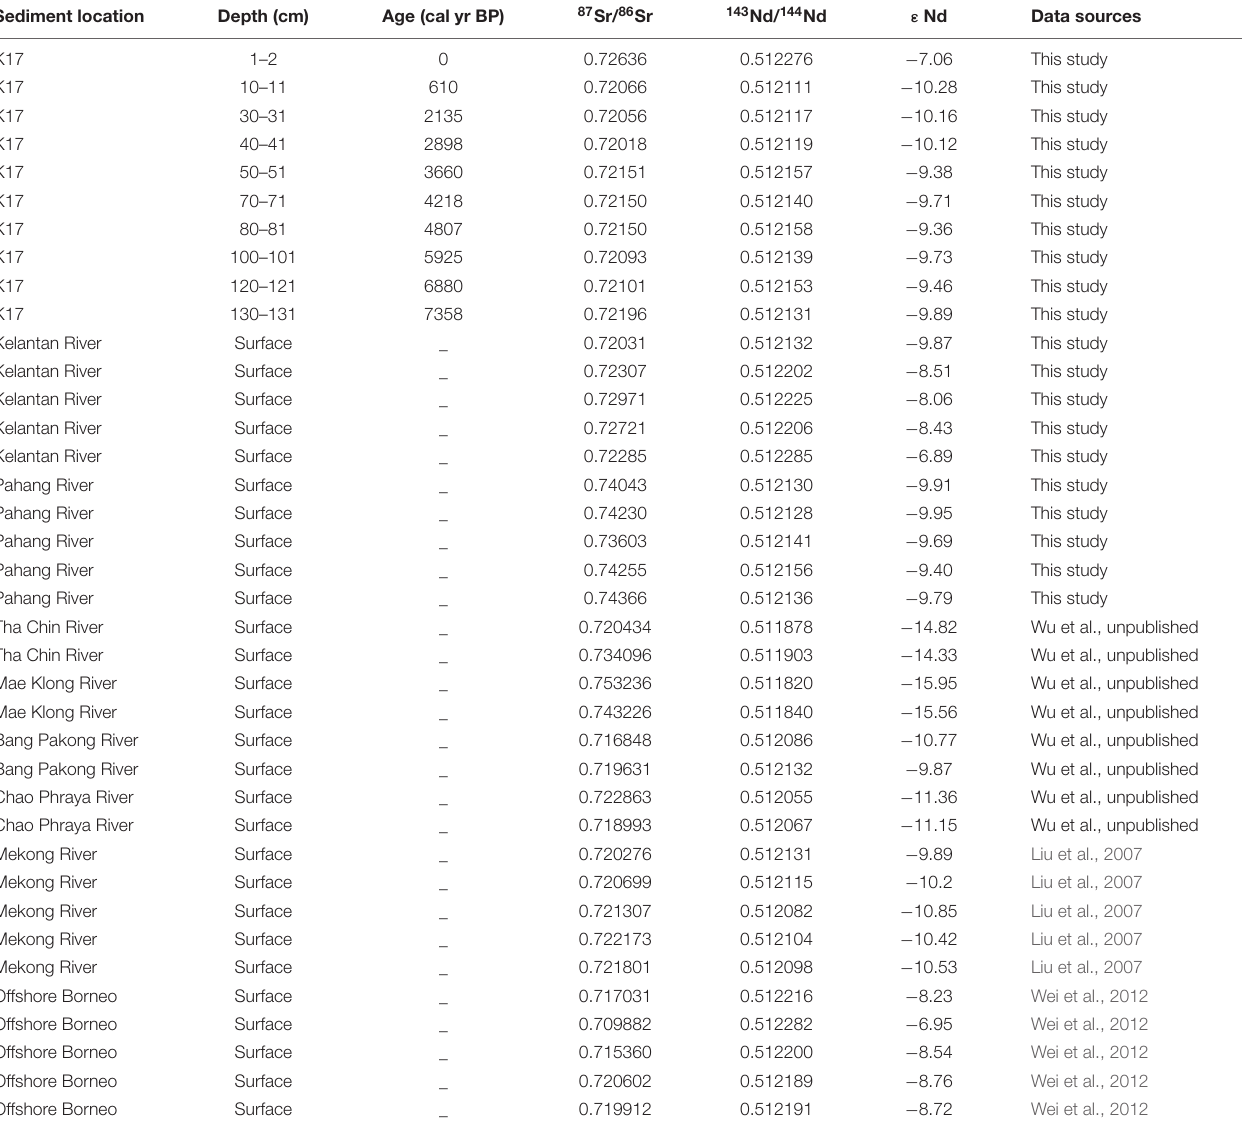
TABLE 3 | Sr and Nd isotopes of sediments in the Core K17 and potential river end members. Sediment